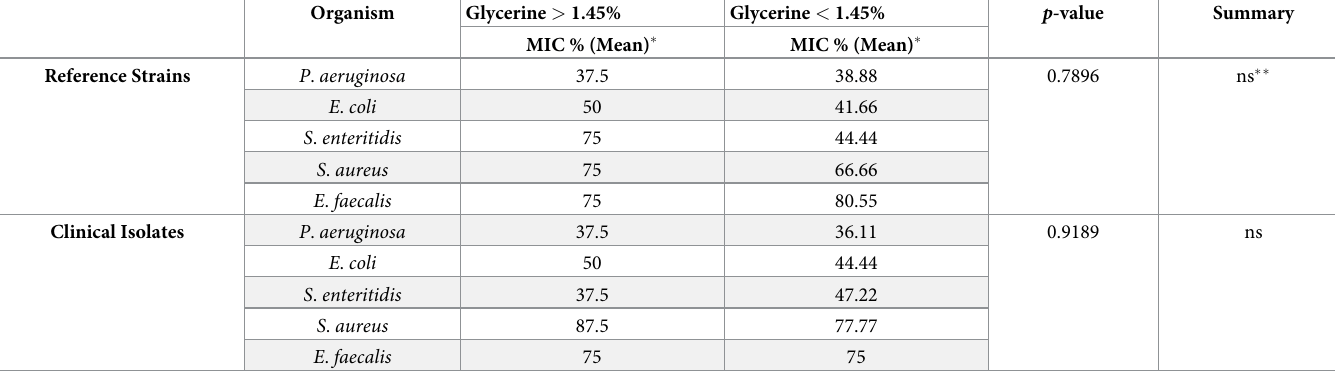
Table 4. This table demonstrates the correlation between glycerin content and the MIC of alcohol-based disinfectants against five bacterial species of ATCC refer- ence strain and clinical